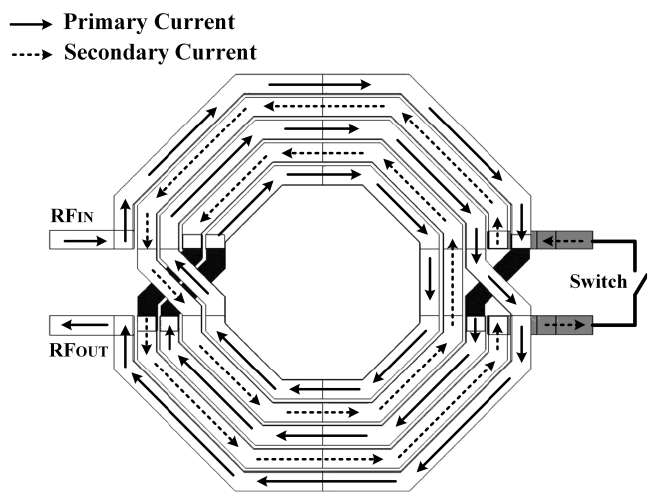
Figure 8. Tunable voltage booster (TVB) architecture.